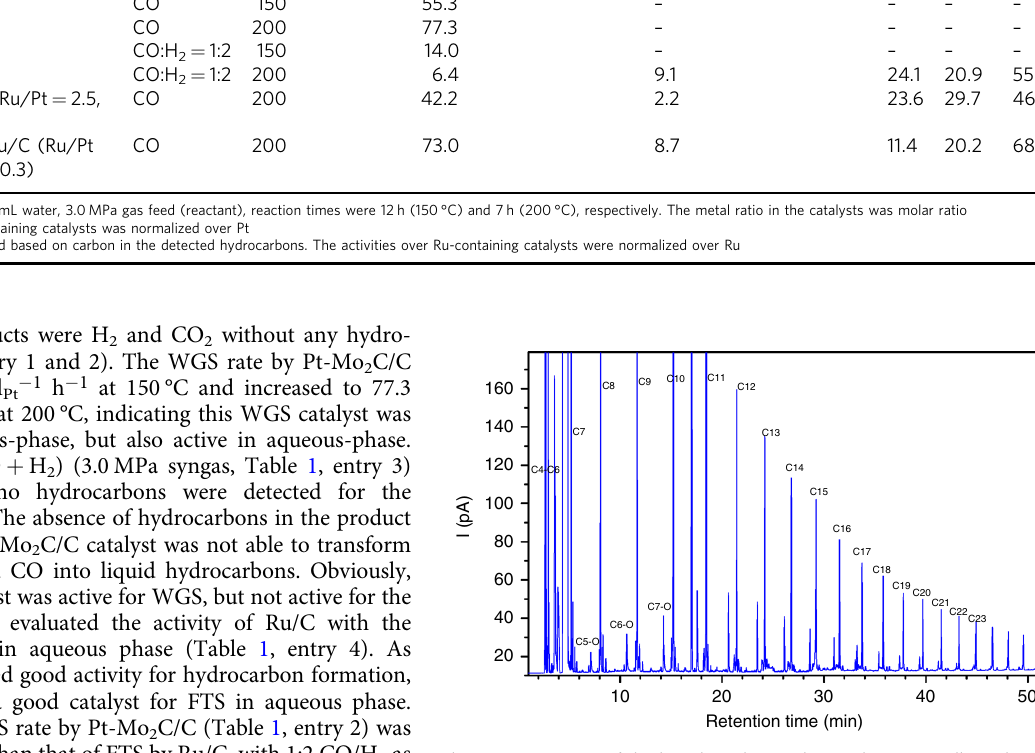
Fig. 1 GC spectrum of the liquid products. The product was collected in the cyclohexane phase obtained on Pt-Mo 2 C/C + Ru/C catalysts for pure CO and H 2 O conversion at 200 °C. The labeled Cn on the graph represents an alkane with n C numbers, and Cn-O represents alcohol with corresponding carbon number. e.g., C5-O stands for pentanol